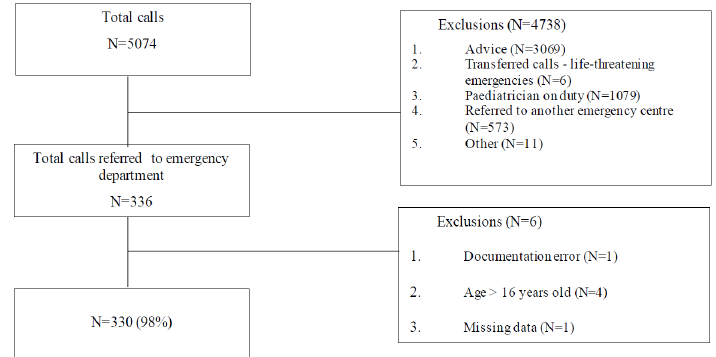
Figure 1. Flowchart of selection and exclusion of calls.